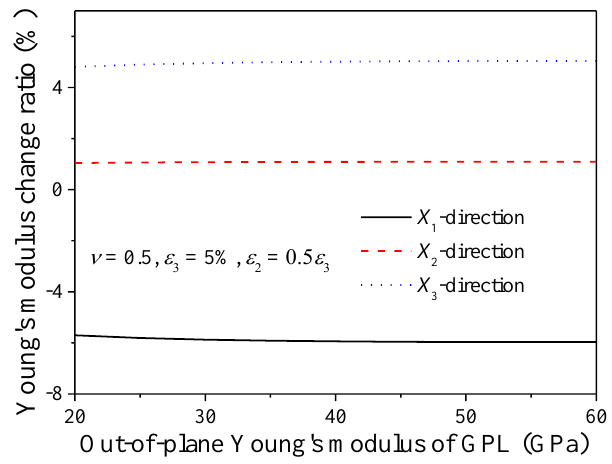
Figure 6. Effect of GPL out-of-plane Young’s modulus on Young’s modulus change ratio of GPL/epoxy nanocomposites.